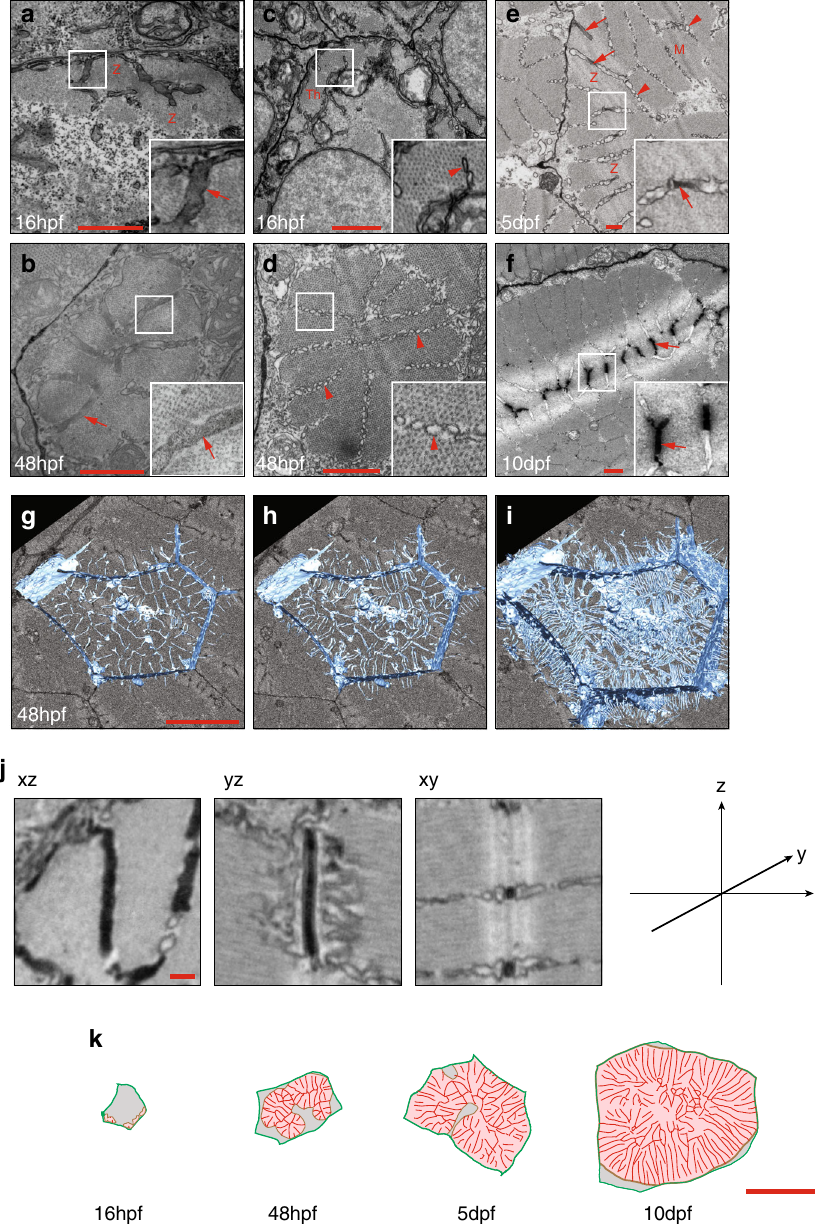
Fig. 2 Ultrastructure of T-tubule development. a – f Transverse orientated transmission electron microscope (TEM) sections showing early T-tubules and sarcoplasmic reticulum. a , b Transverse sections through the Z line (Z) at 16 and 48 hpf. Electron dense, ferricyanide stained tubules are denoted by arrows. c , d Equivalent transverse sections taken towards the centre of the sarcomere, some distance from the Z-line. Arrowheads denote sarcoplasmic reticulum, which has an unstained lumen and a beaded appearance. e , f Oblique sections at 5 and 10 dpf show both ferricyanide stained, electron dense tubules (arrows) and sarcoplasmic reticulum (arrowheads). M, M-line, Z, Z-line. See also Supplementary Movie 3 ( g – i ) TEM images were derived from two individual animals per time point and speci fi c observations described were noted in >12 individual cells. Serial blockface electron microscopy and 3D reconstruction shows association of T-tubules with myo fi bril furrows or splits at level of the Z-line (see also Supplementary Movie 3). Images are derived from two individual animals and images shown are representative of both ( j ) Single planes from a focussed ion beam volume enables precise measurements of tubule morphometrics (quantitative data are shown in Fig. 3g). This analysis is derived from one individual. k Tracing of TEM images illustrates the architecture of myo fi bril furrows and associated tubules. Red, tubules/furrows; pink, myo fi brils; green, sarcolemma. Full masks are shown in Fig. 3a – c. These analyses are derived from one individual per time point. Scale bars; ( a – f ) 1 µ m, ( g , h ) 10 µ m, ( j ) 200 nm, ( k ) 10 µ association of longitudinal sarcoplasmic reticulum (identi fi able by microscopy (TEM) sections to label the T-tubules 8 and distin- its beaded appearance and lower electron density) with the early guish them from sarcoplasmic reticulum (SR). Sections taken at myo fi brillar material (arrowhead, Fig. 2c). By 48 hpf, the myo fi - 16 hpf showed electron dense, transverse oriented tubular mem- brillar bundles, analogous to previously described nascent myo- branes associated with the forming Z-lines (arrow Fig. 2a). By fi brils 14 developed longitudinal furrows as they increased in contrast, transverse sections taken towards the centre of the sarcomere some distance away from the Z-lines showed diameter consistent with the Goldspink model of myo fi brillar